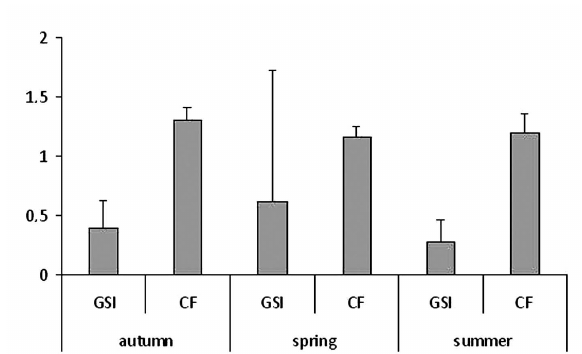
Fig . 4. – Seasonal variation of the gonadosomatic index (GSI) and relative condition factor (CF) of Labrus mixtus from the Adriatic Sea.